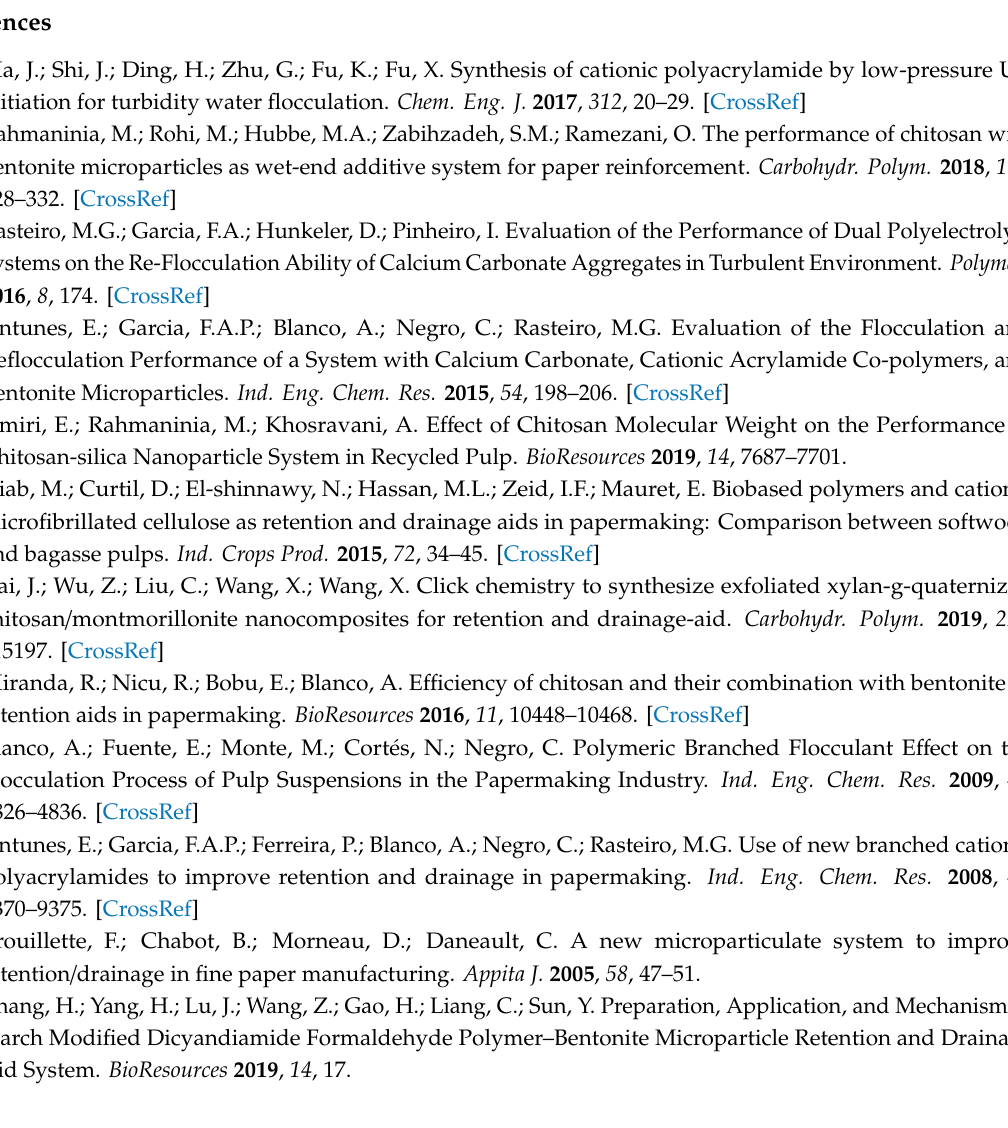
Figure S1: FTIR spectra of the PSSNa and